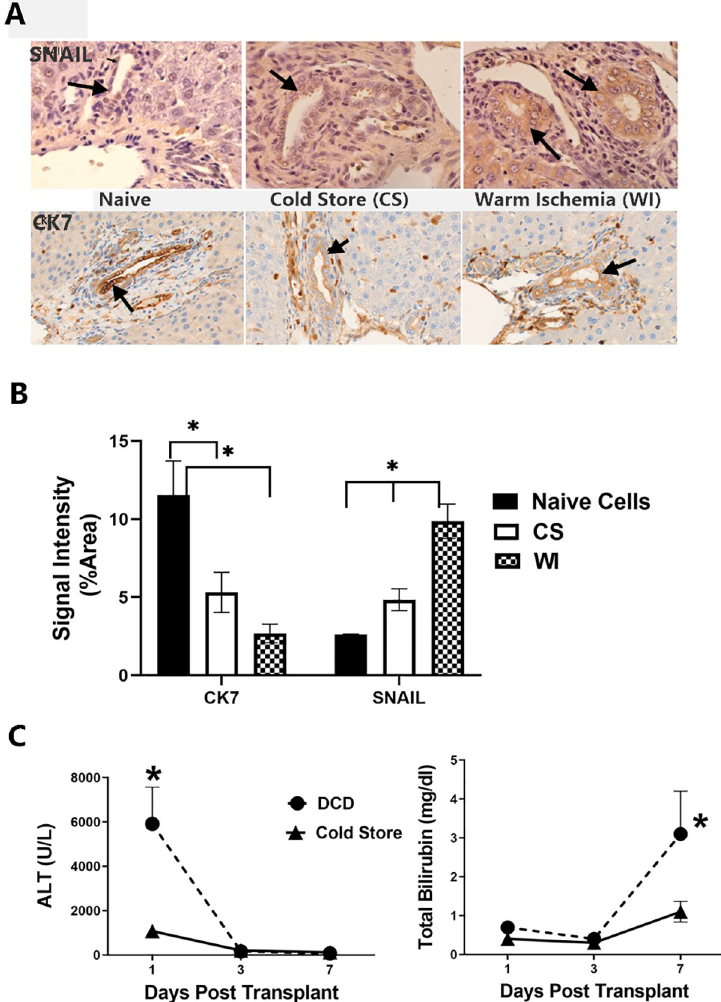
Fig 8. Rat liver ischemic cholangiopathy model. Immunohistochemical analysis of expression of SNAIL and CK-7 from rat liver tissue 7 days after transplantation into syngeneic rats. Sections were prepared from fresh non-ischemic livers, from livers with 24 hours of cold storage time in UW solution, and from livers with both 24 hours of cold storage and 30 minutes of warm ischemia prior to liver recovery from the donor (panel A). Arrows show individual cholangiocytes staining for the selected markers. Quantitation of stain intensity shown in panel A was done for each of the 5 livers from each group using ImageJ analysis. These results are graphically shown in Panel B, � P < 0.05. Panel C shows the serum ALT and Total Bilirubin values measured in liver isograft recipients from the time of transplantation until 7 days after transplantation. Values are mean +/- SD from 5 rats, � P < 0.05 relative to the control rats (24 hours of cold storage